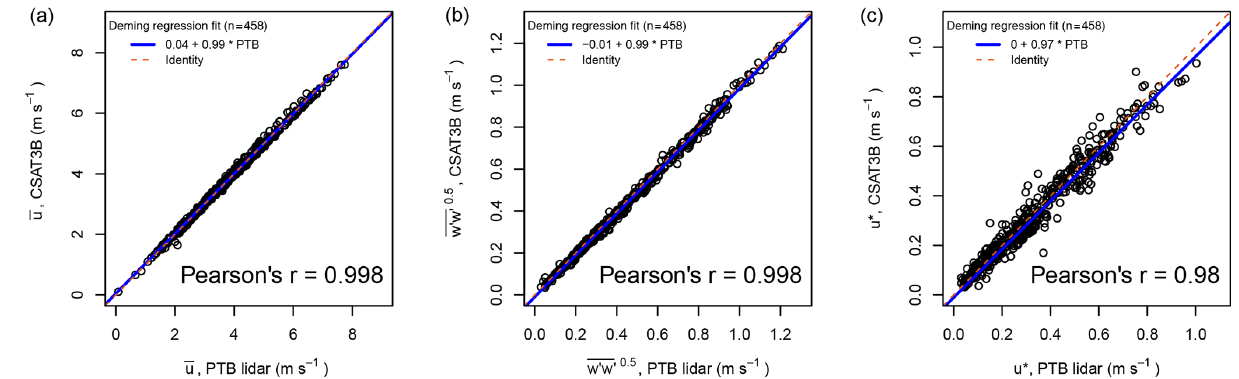
Figure 5. Comparison for mean wind velocity (a) , standard deviation of the vertical velocity component (b) , and friction velocity (c) , including the regression equation and correlation coefficient. The solid blue line indicates the Deming regression and the dashed red line indicates identity.